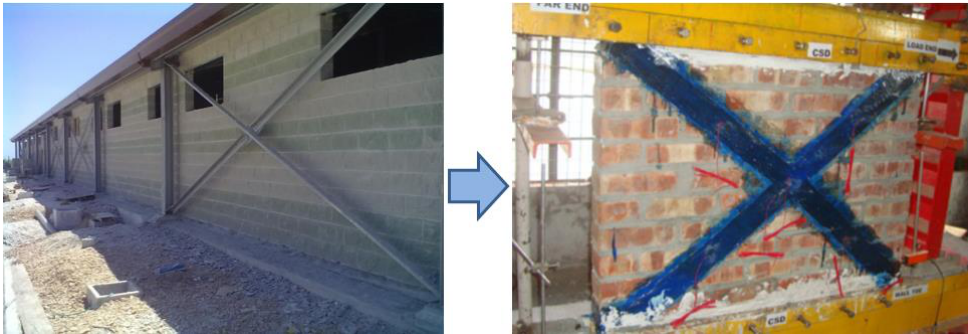
Figure 2. Statics of the resisting mechanism: from a steel structure to a CFRP-reinforced wall [13].